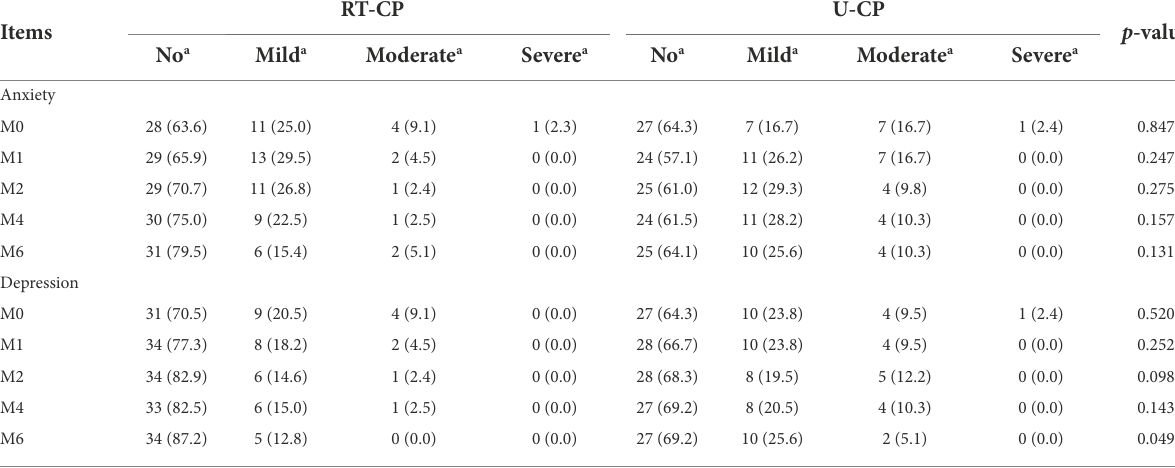
TABLE 3 Comparison of anxiety and depression severity among the older PTC patients.